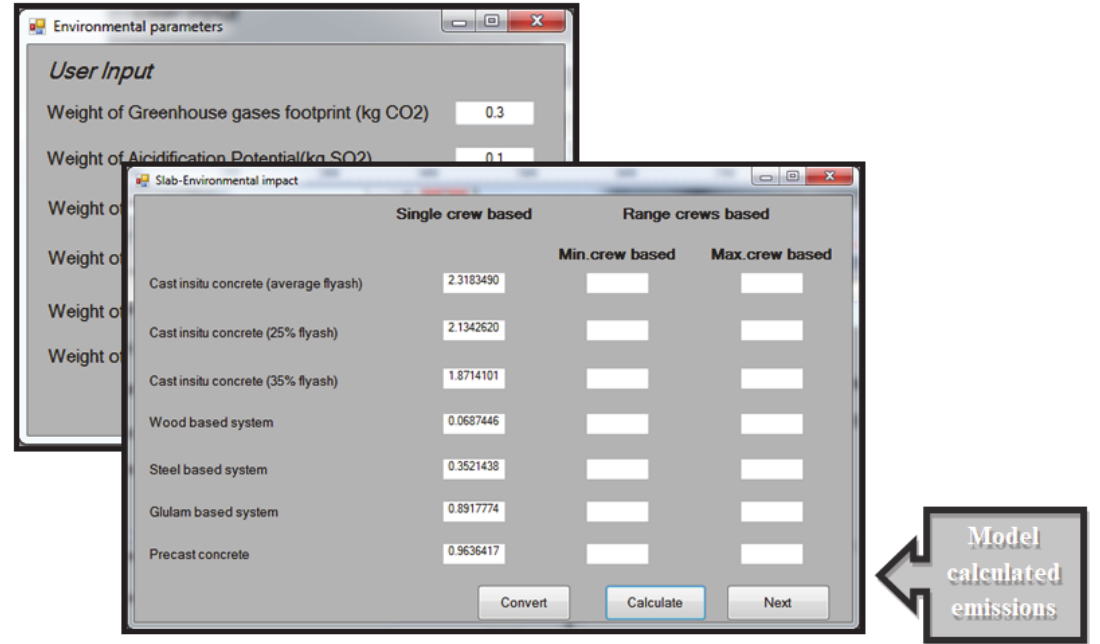
Fig. 2. Calculated environmental impact of the developed